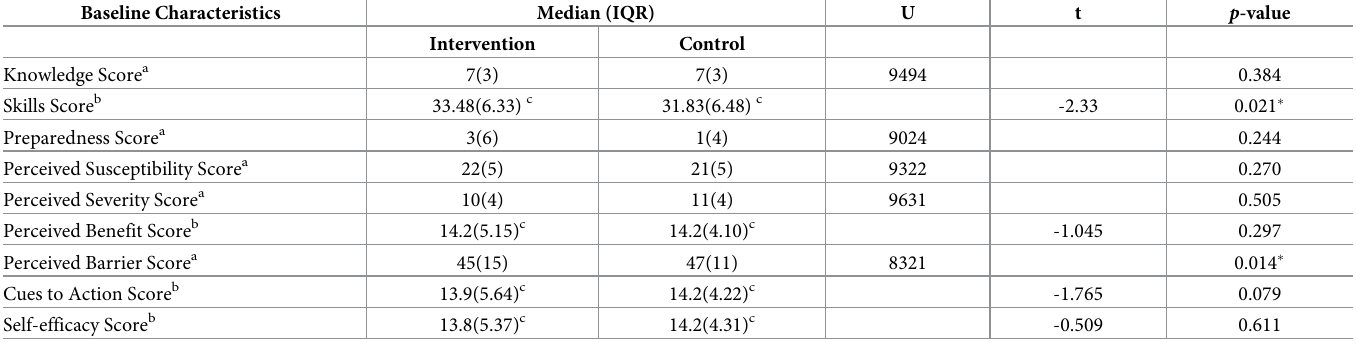
Table 3. Baseline result of knowledge score, skills score, preparedness score, susceptibility, severity, benefit, barrier, cues to action, and self-efficacy score between intervention and control group.